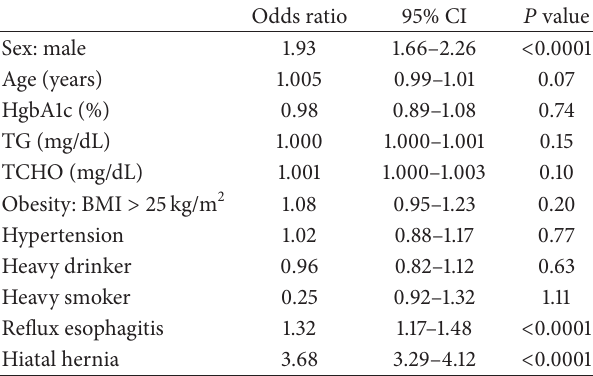
Table 4: Predictors for Barrett’s